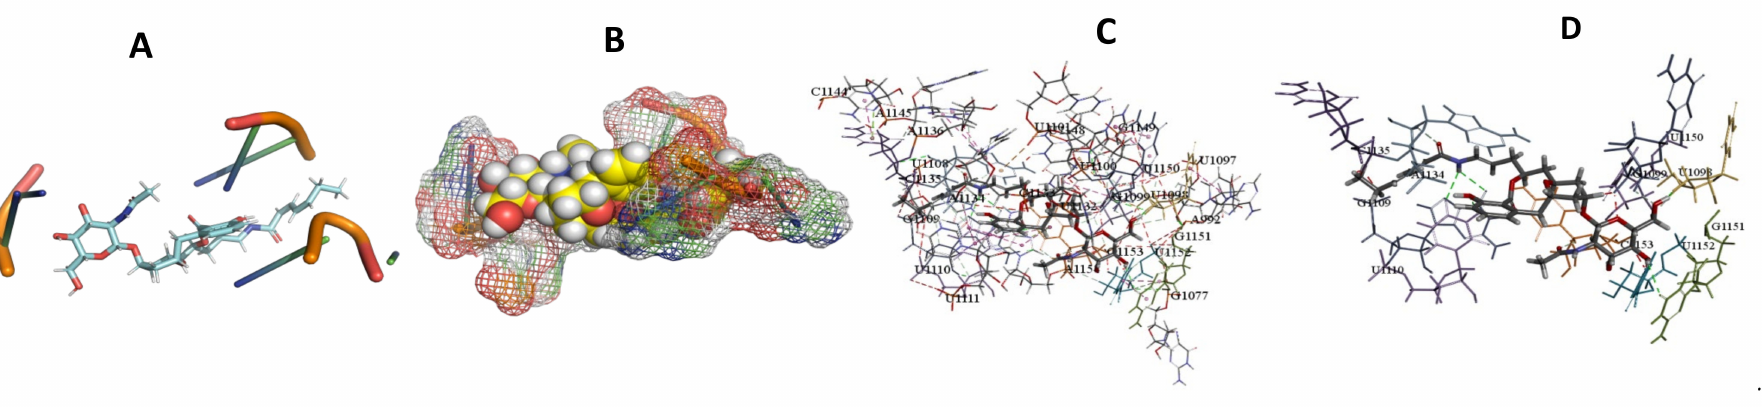
Figure 11. T. cruzi + Apicuralen ( A ): Best binding pose and nucleotides involved. ( B ): Schematic binding pocket. ( C ): shows the Nucleotides component that re involved in binding. ( D ): Shows the main bonds involved between the compound and the nucleotide